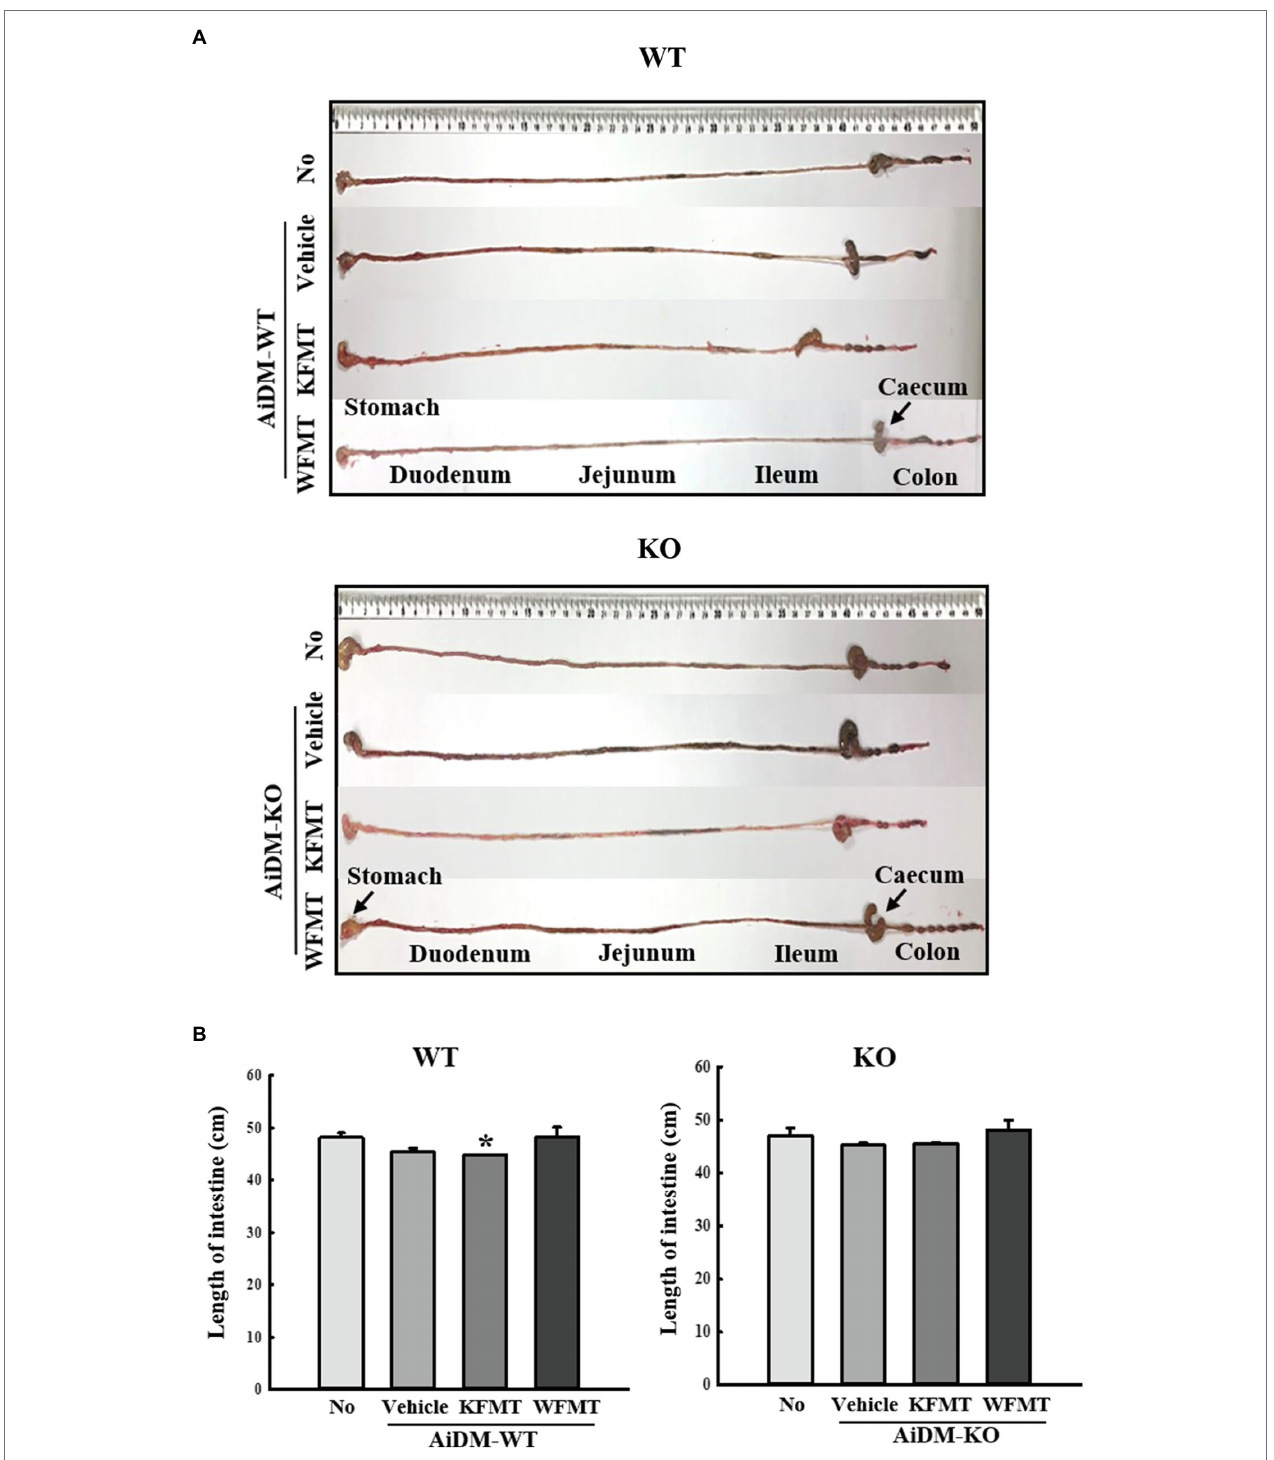
FIGURE 5 | Intestinal length in FMT mice. (A) Representative image showing an entire intestine. The total intestinal tract was excised from a mouse of each subset group. Morphology was observed using a digital camera. (B) Total length of intestine. The total length from stomach to anus was measured with a ruler. Three to five mice per group were used in the collection of intestines, and the intestine length was measured twice. The data are reported as mean ± SD values. * p < 0.05 compared with the No-treated group. WT, wild type; KO, knockout; FMT, fecal microbiota transplantation; KFMT, knockout mice FMT; WFMT, wild-type mice FMT; AiDM, antibiotics-induced depletion of microbiota; AiDM-WT, AiDM-wild-type mice; and AiDM-KO, AiDM-knockout